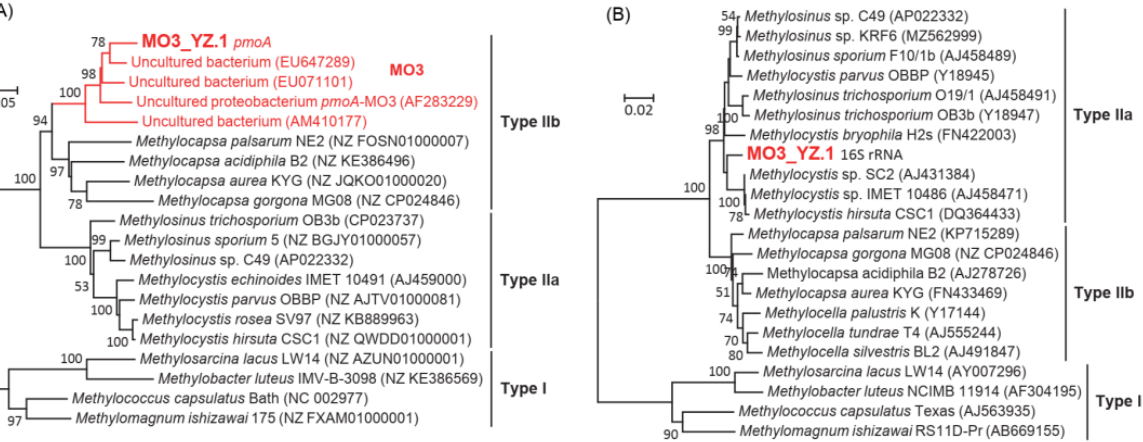
Figure 4. Phylogenetic relationship of MAG MO3_YZ.1 with its relatives on the basis of the full-length pmoA ( A ) and 16S rRNA ( B ) genes. Neighbor-joining trees were constructed using the MEGA 6.06 with 1000 replicates. Only bootstrap values higher than 50% are given at the branch nodes. Scale bars indicate 0.05 or 0.02 substitutions per nucleotide